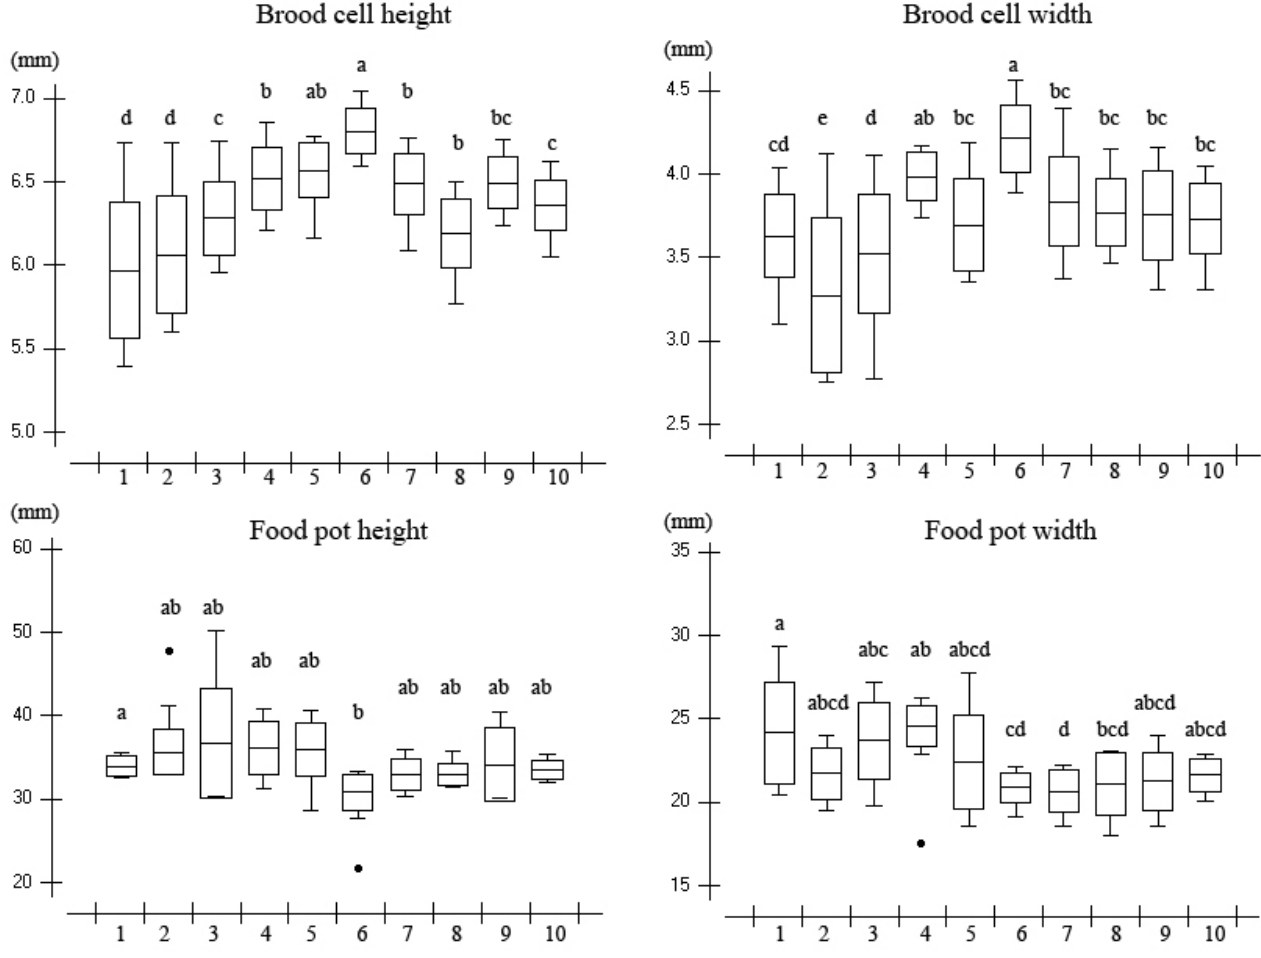
Fig 6 . Height and width (mean, stand. dev., max., min.) of brood cells and food pots of 10 Tetragona clavipes colonies. Letters (a, b, c, d) indicates grouping differences from ANOVA and Tukey